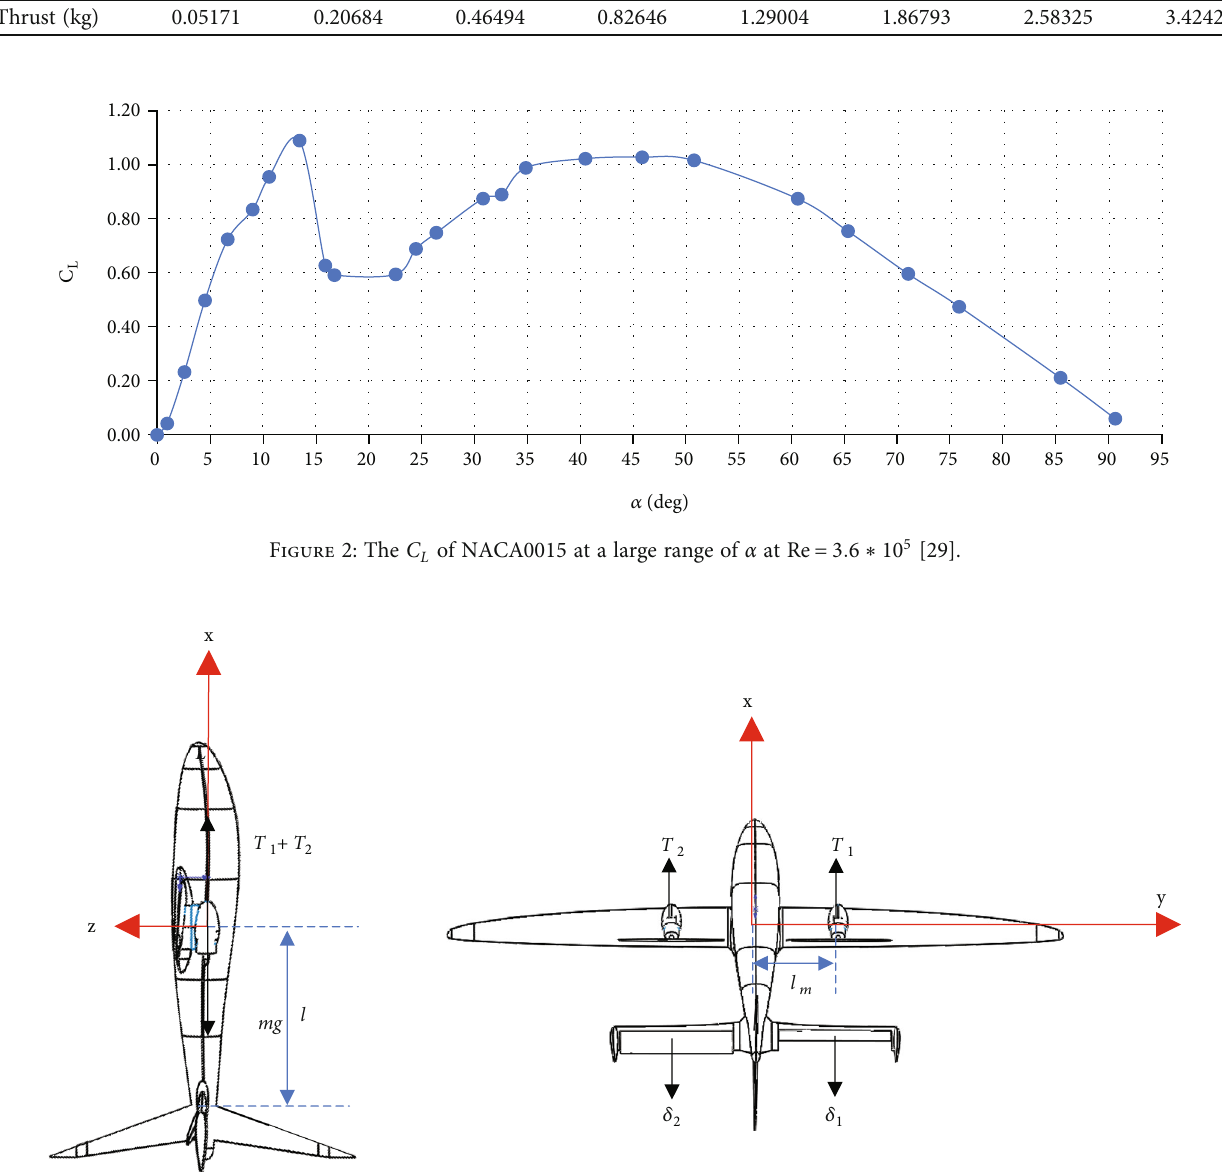
Figure 3: Egretta reference frame and free body diagram at hovering.